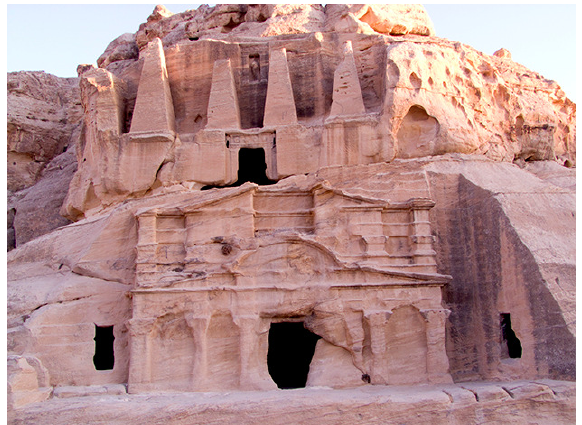
Figure 7. The Obelisk Tomb and the Bab As-Siq Triclinium in